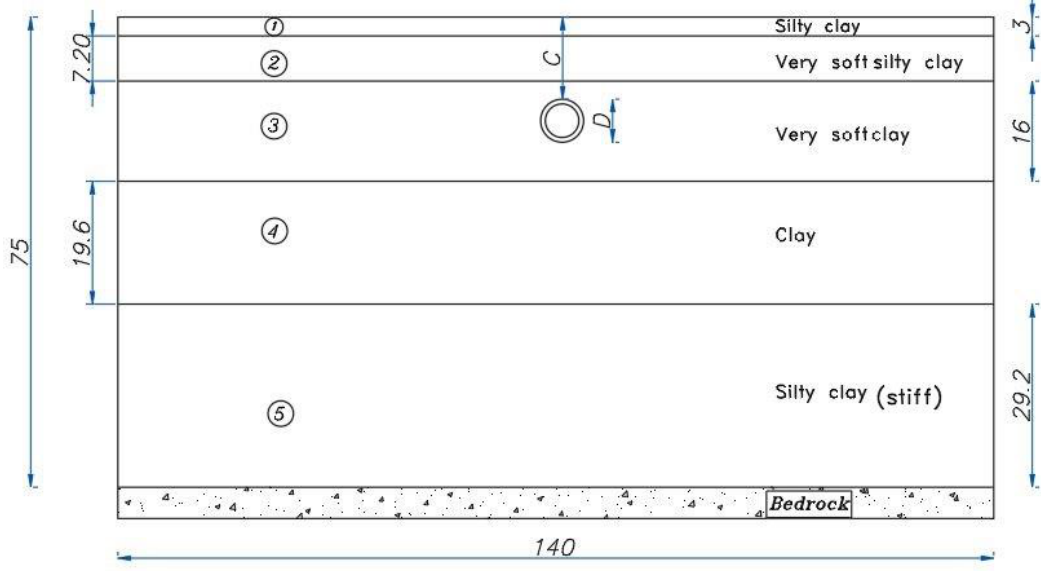
Figure 8. The soil–tunnel system. Table 1. Parameters of the constitutive model.